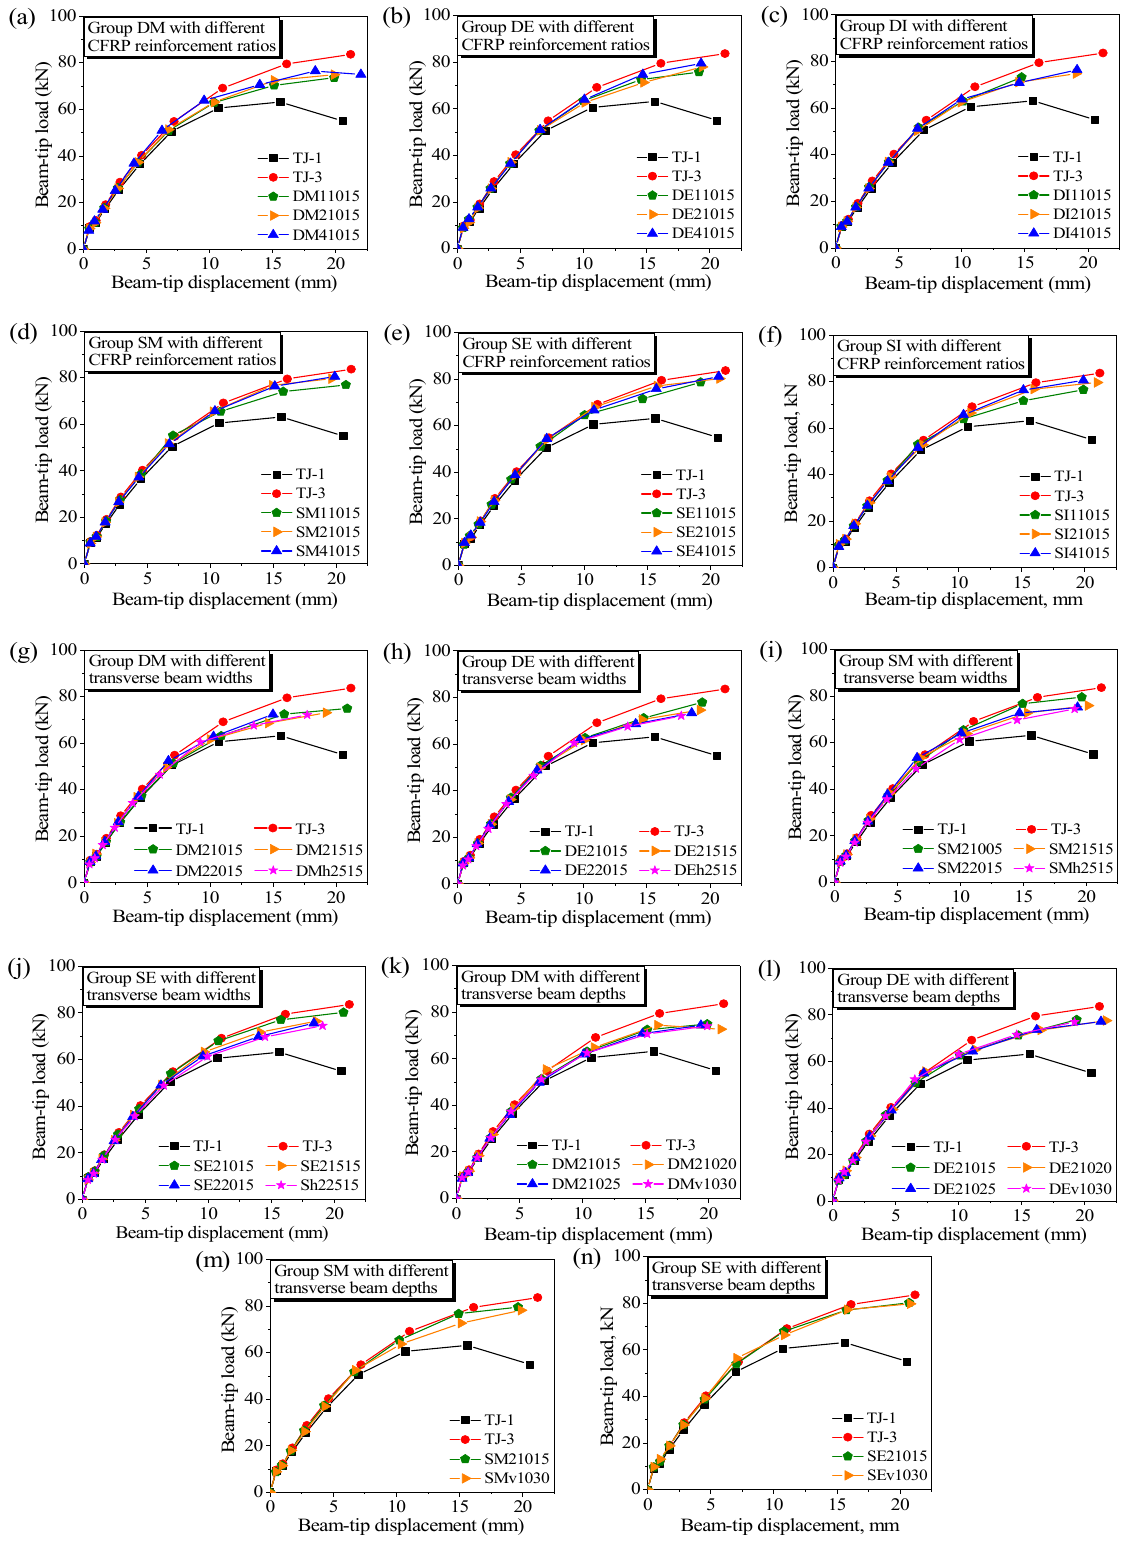
Figure 6. Comparison of the load-displacement curves in different groups. ( a ) Group DM with differ- ent CFRP reinforcement ratios; ( b ) Group DE with different CFRP reinforcement ratios; ( c ) Group DI with different CFRP reinforcement ratios; ( d ) Group SM with different CFRP reinforcement ratios; ( e ) Group SE with different CFRP reinforcement ratios; ( f ) Group SI with different